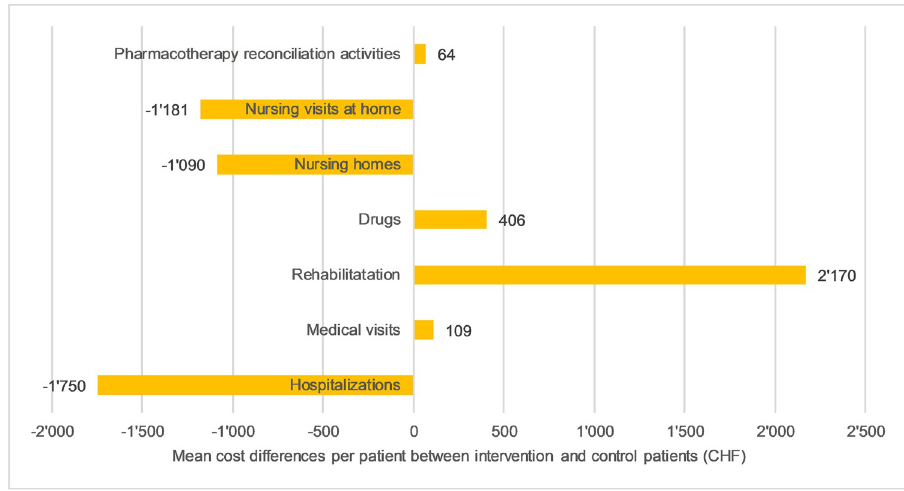
Fig 1. Mean cost differences per patient (CHF) between intervention and control patients, broken down by cost categories, all countries. Note: A positive cost difference (bar on the right hand-side) means that costs were higher in the intervention arm, while a negative cost difference (on the left hand-side), indicates that costs were higher in the control arm.